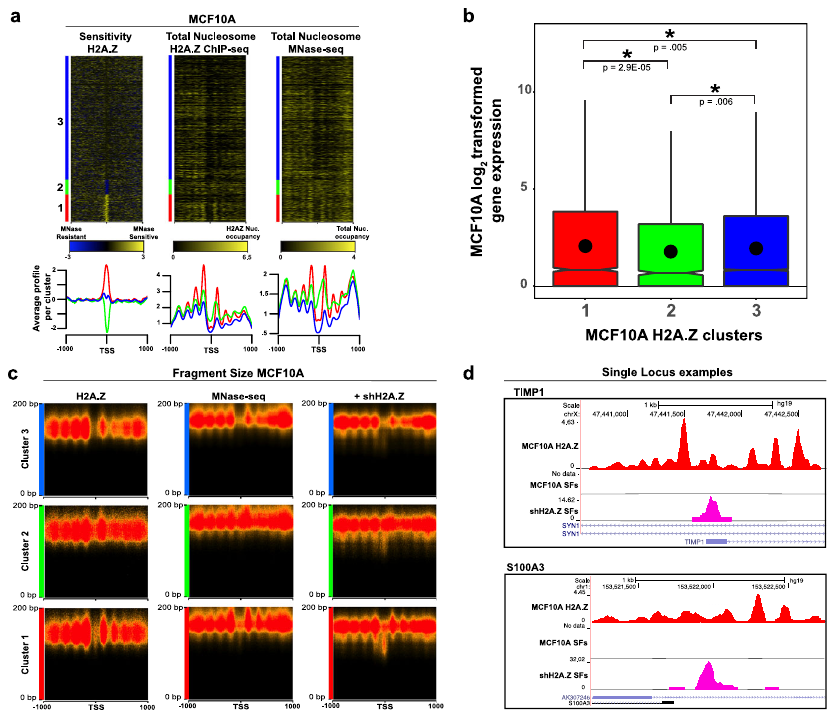
Fig. 4 The MNase accessibility of the H2A.Z nucleosome at the TSS correlates with the level of expression. a H2A.Z MNase sensitivity data was sorted with a clustering window ±50 bp surrounding the TSS by k-means clustering ( k = 3) to produce a heat map that reveals H2AZ MNase resistant and sensitive nucleosomes at the TSS in MCF-10A cells. Adjacent heat maps display H2A.Z and total nucleosome pro fi les dependent on the H2A.Z MNase sensitivity sort. Below each heatmap are average nucleosomal occupancy pro fi les. b Gene expression box plots for each TSS H2A.Z MNase sensitivity cluster. P -values determined by two-tailed Welch ’ s t-test assuming unequal variances. Box plots represent the data in quartiles with the median shown as a notch, with the middle 50% of the data contained in the box, and the minima and maxima shown with the upper and lower whiskers representing Q1 and Q4. RNA-seq was performed in three independent biological replicates. c Total MNase digestion fragment size distribution for each respective cluster in panel a, centred on the 1000 bp surrounding the TSS. DNA fragment size analysis was performed on immunoprecipitated H2A.Z nucleosomes, total MTSS- seq nucleosomes, and shH2A.Z nucleosomes for MCF10-A cells. Following H2A.Z knockdown, a distinct population of subnucleosomal-sized DNA fragments is observed in the red and green clusters 1 and 2, respectively. d Representative promoters, TIMP1 and S100A3 demonstrating the appearance of subnucleosomal-sized DNA fragments at the TSS following H2A.Z